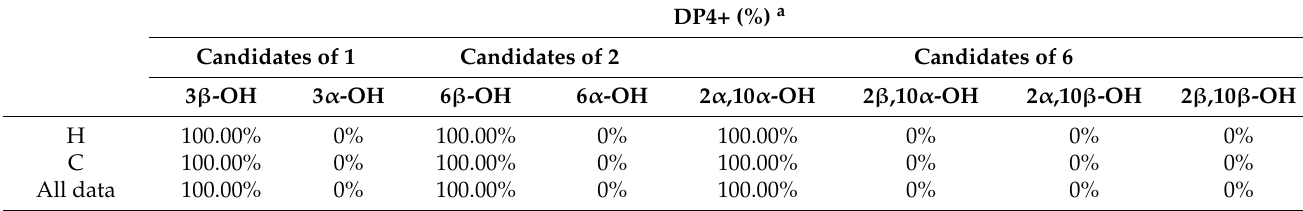
Figure 3. Selected NOE correlations of 1 and 4 – 6 (a: deshielded proton; b: shielded proton). Table 3. DP4+ probabilities for possible candidates of compounds 1 , 2 , and 6 Table 2. 13 C NMR spectroscopic data of compounds 1 – 6 .